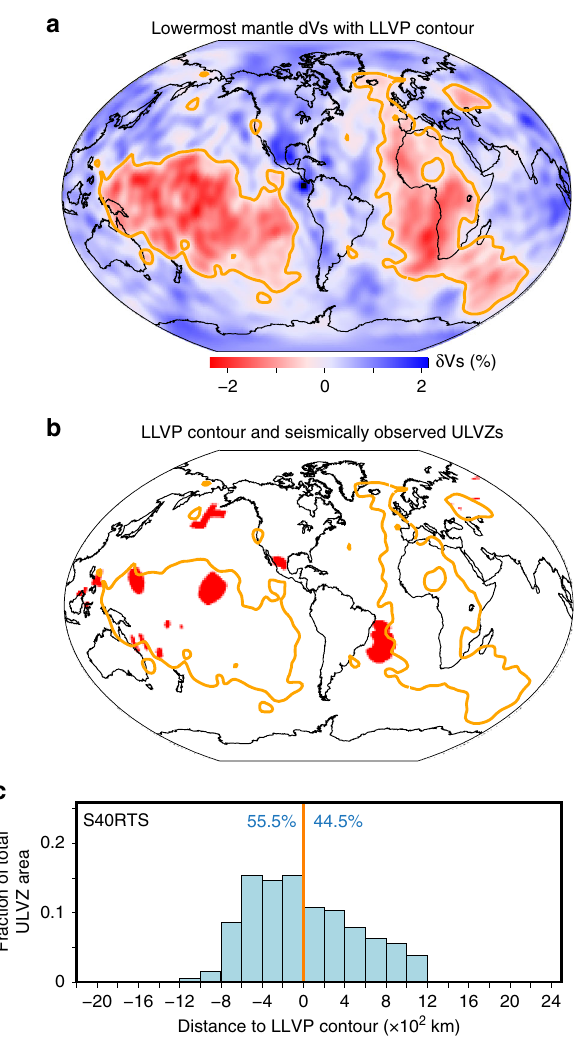
Fig. 5 Seismic observation of ULVZs and LLVP edges. a Seismic shear-wave tomography model at 2800 km depth (S40RTS), with the LLVP edges shown by orange lines that surround 30% of the CMB area. b LLVP edges ( orange lines ) along with the ULVZ Fresnel zone patches ( red , discretized in 0.5 × 0.5 degree cells) for all ULVZ waveform studies of core re fl ected waves (ScS, ScP, PcP). c The minimum distance of every ULVZ cell to LLVP edges. For each distance in the horizontal axis , the corresponding vertical axis shows the areal fraction of total ULVZ area. The thick orange line denotes the LLVP margin. Negative distance represents outside of LLVPs and positive distance represents inside of LLVPs. The percent area outside vs. inside of LLVPs is indicated by the blue